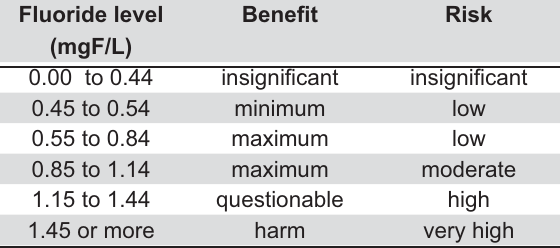
Table 3- (cid:9) "(cid:18)(cid:7)(cid:11)(cid:11)(cid:5)(cid:30)(cid:20)(cid:7)(cid:12)(cid:5)(cid:14)(cid:15)(cid:9) (cid:14)(cid:16)(cid:9) (cid:6)(cid:3)(cid:14)(cid:4)(cid:5)(cid:27)(cid:19)(cid:9) (cid:18)(cid:19)#(cid:19)(cid:18)(cid:11)(cid:9) (cid:5)(cid:15)(cid:9) (cid:21)(cid:7)(cid:12)(cid:19)(cid:4)(cid:9) for locations where the mean of maximum annual temperatures are between 26.3°C and